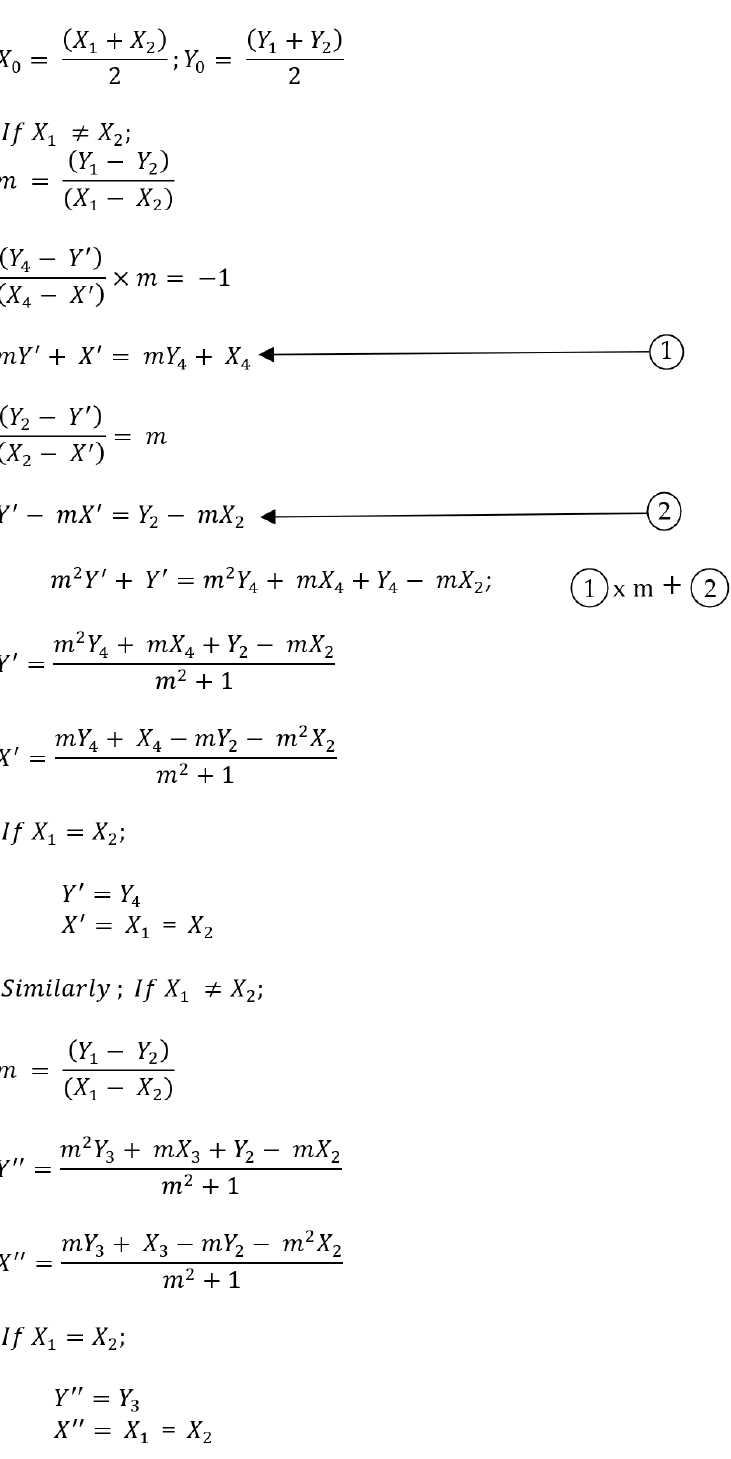
Figure A1. Vector calculation based on mouth landmark coordinates.